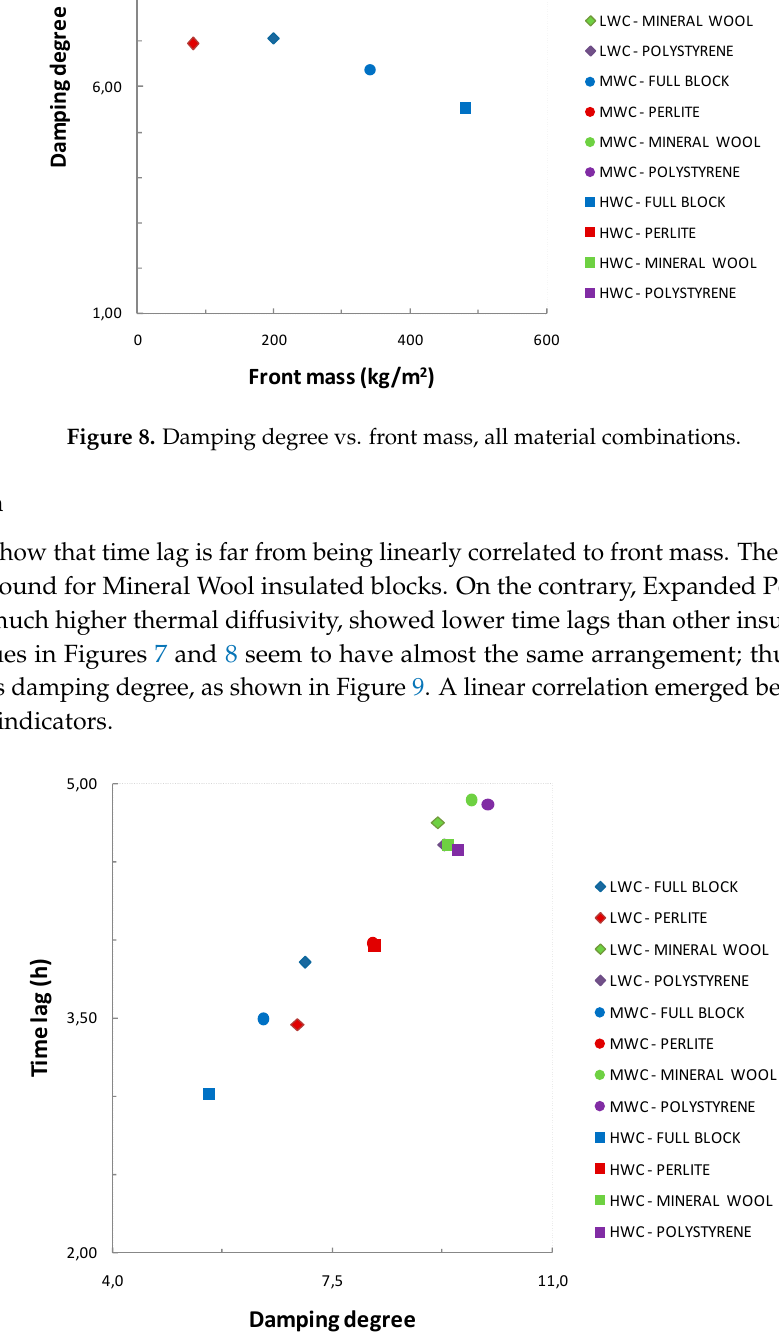
Figure 9. Time lag (in hours) vs. damping degree, all material combinations.